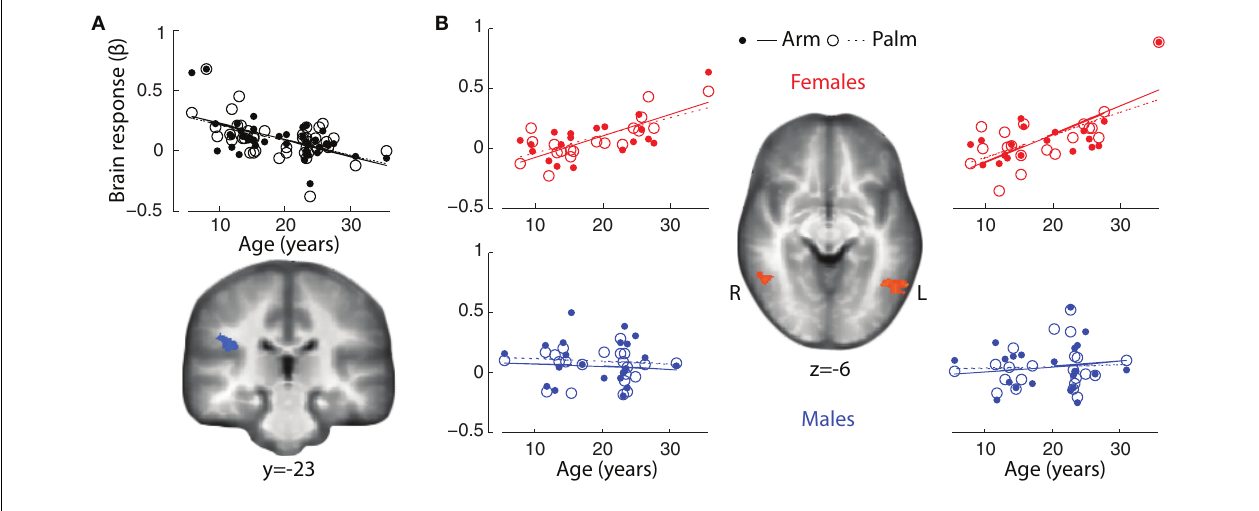
correlation plots show male brain responses extracted from the female regions, and include all males (including those excluded from the statistical analysis).